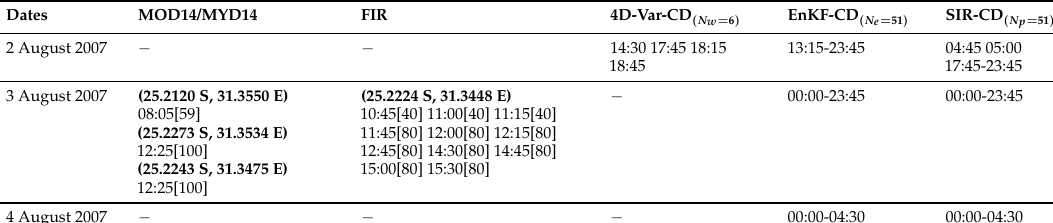
Table 8. Table corresponds to results in Figure